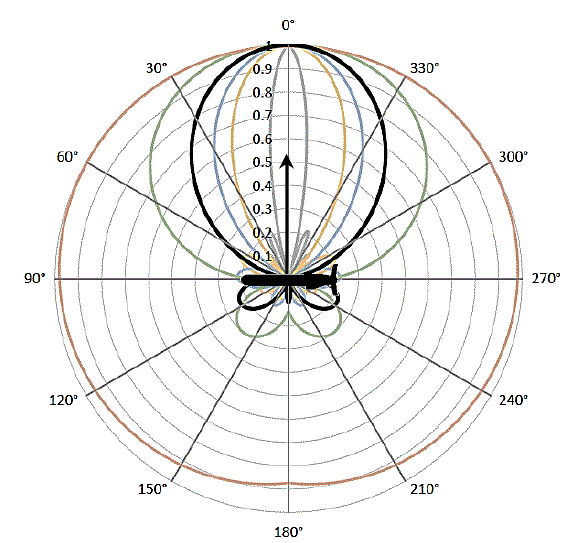
Figure 3. Various radiation patterns of the GPS receiver antenna onboard of missile